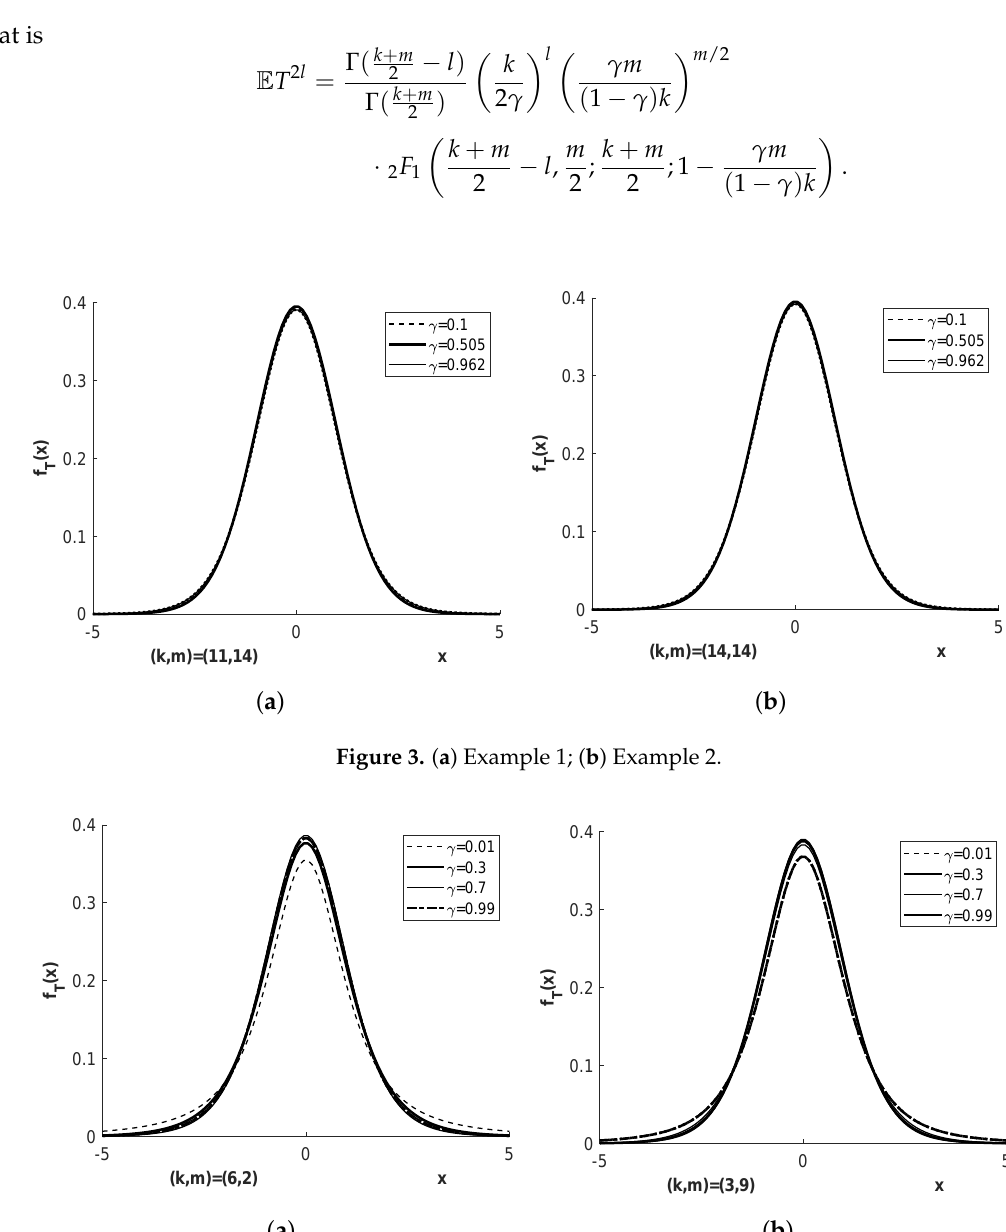
Figure 4. ( a ) Example 3; ( b ) Example